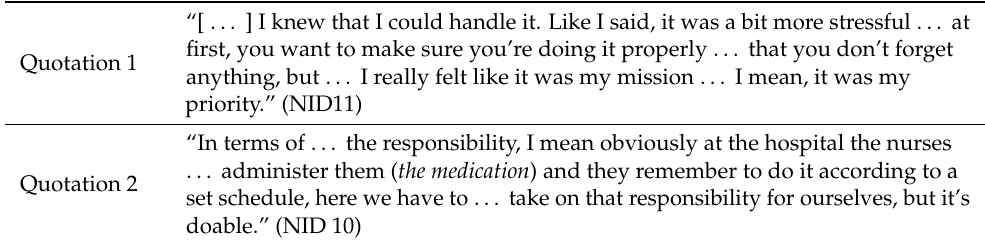
Table 2. Exemplar quotations from interviewed parents for the theme: Parents’ motivation toward adhering to home-based oral chemotherapy.